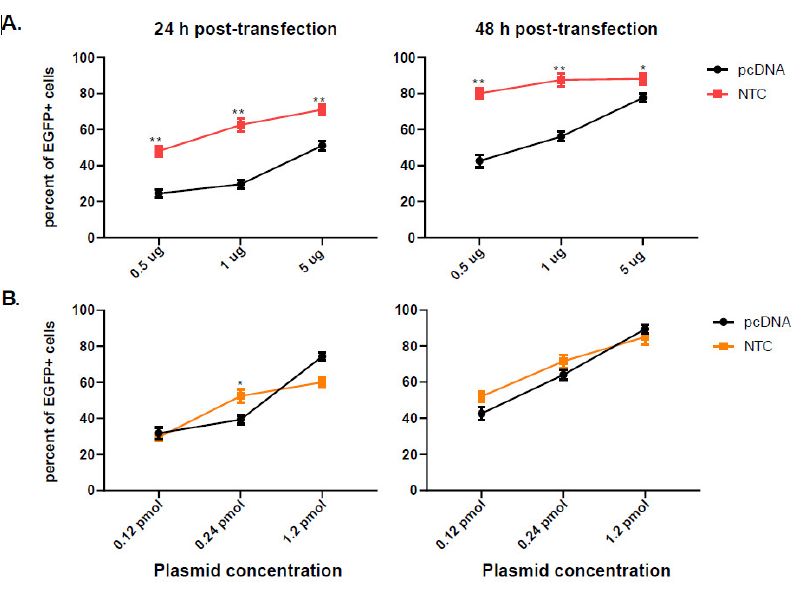
Figure 1. EGFP positive COS-7 cells evaluated by flow cytometry. COS-7 cells were transfected with equal concentration ( A ) or equimolar concentrations ( B ) of pcDNA-EGFP or NTC-EGFP. 24 h (left graphs) and 48 h (right graphs) later, cells were harvested and EGFP positive cells were analyzed by flow cytometry. 10,000 events were acquired by Partec instrument. The results are representative of two separate experiments; error bars indicate the within-assay repeats in each experiment. Data were compared using Student’s t -test. * p < 0.05, ** p < 0.01.